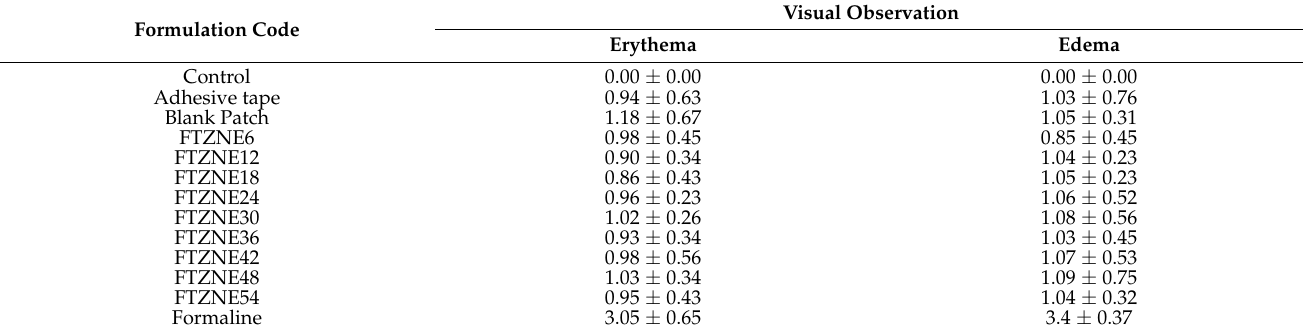
Table A5. Skin irritation studies of Tizanidine transdermal patch, n = 3, mean ± S.D.